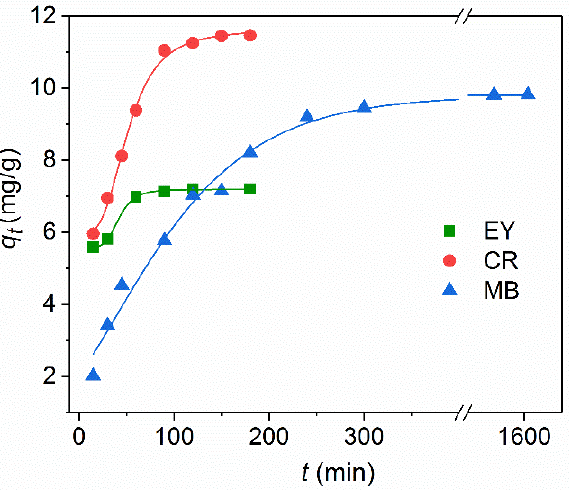
Figure 8. The effect of contact time on the dye adsorption for Fe 3 O 4 @SiO 2 @NH 2 NPs at 25 °C. Experimental conditions: C 0 = 30 mg/L, m (NPs) = 3 mg in V = 1.5 mL.